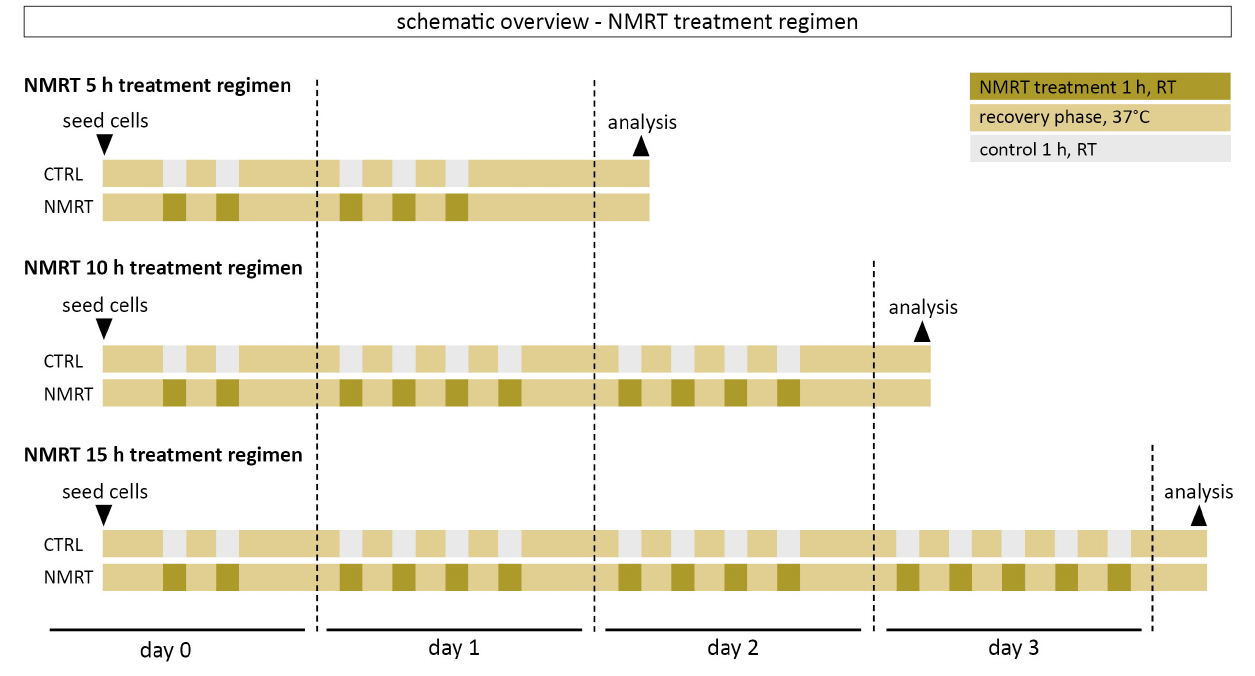
FIGURE 1 | Schematic overview of the NMRT treatment regimen. The first NMRT treatment cycle was conducted 5 h after seeding of